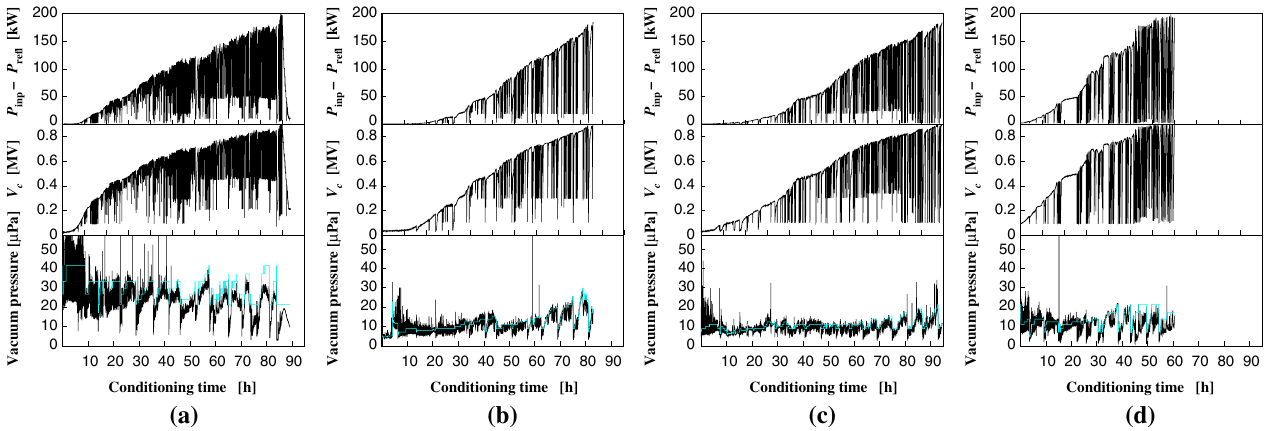
FIG. 2. Conditioning histories until V c reached 0.90 MV with data points recorded every 10 s. P to (reflected from) the cavity. Data with no input rf power, data obtained while the input rf power was kept constant, and data used to tune the control system or klystron are excluded here. The light blue lines indicate the reference vacuum pressure specified in the automatic conditioning by computer control. If the vacuum pressure is higher than the reference pressure, the rf power is stepped down until the vacuum pressure becomes lower than the reference pressure, and then the power is gradually stepped up as long as the vacuum pressure remains lower than the reference pressure. The step-up slope is proportional to the difference between the reference and vacuum pressures. (a) DR cavity No. 0 (2012); (b) DR cavity No. 1 (2013); (c) DR cavity No. 2 (2014); (d) DR cavity No. 0